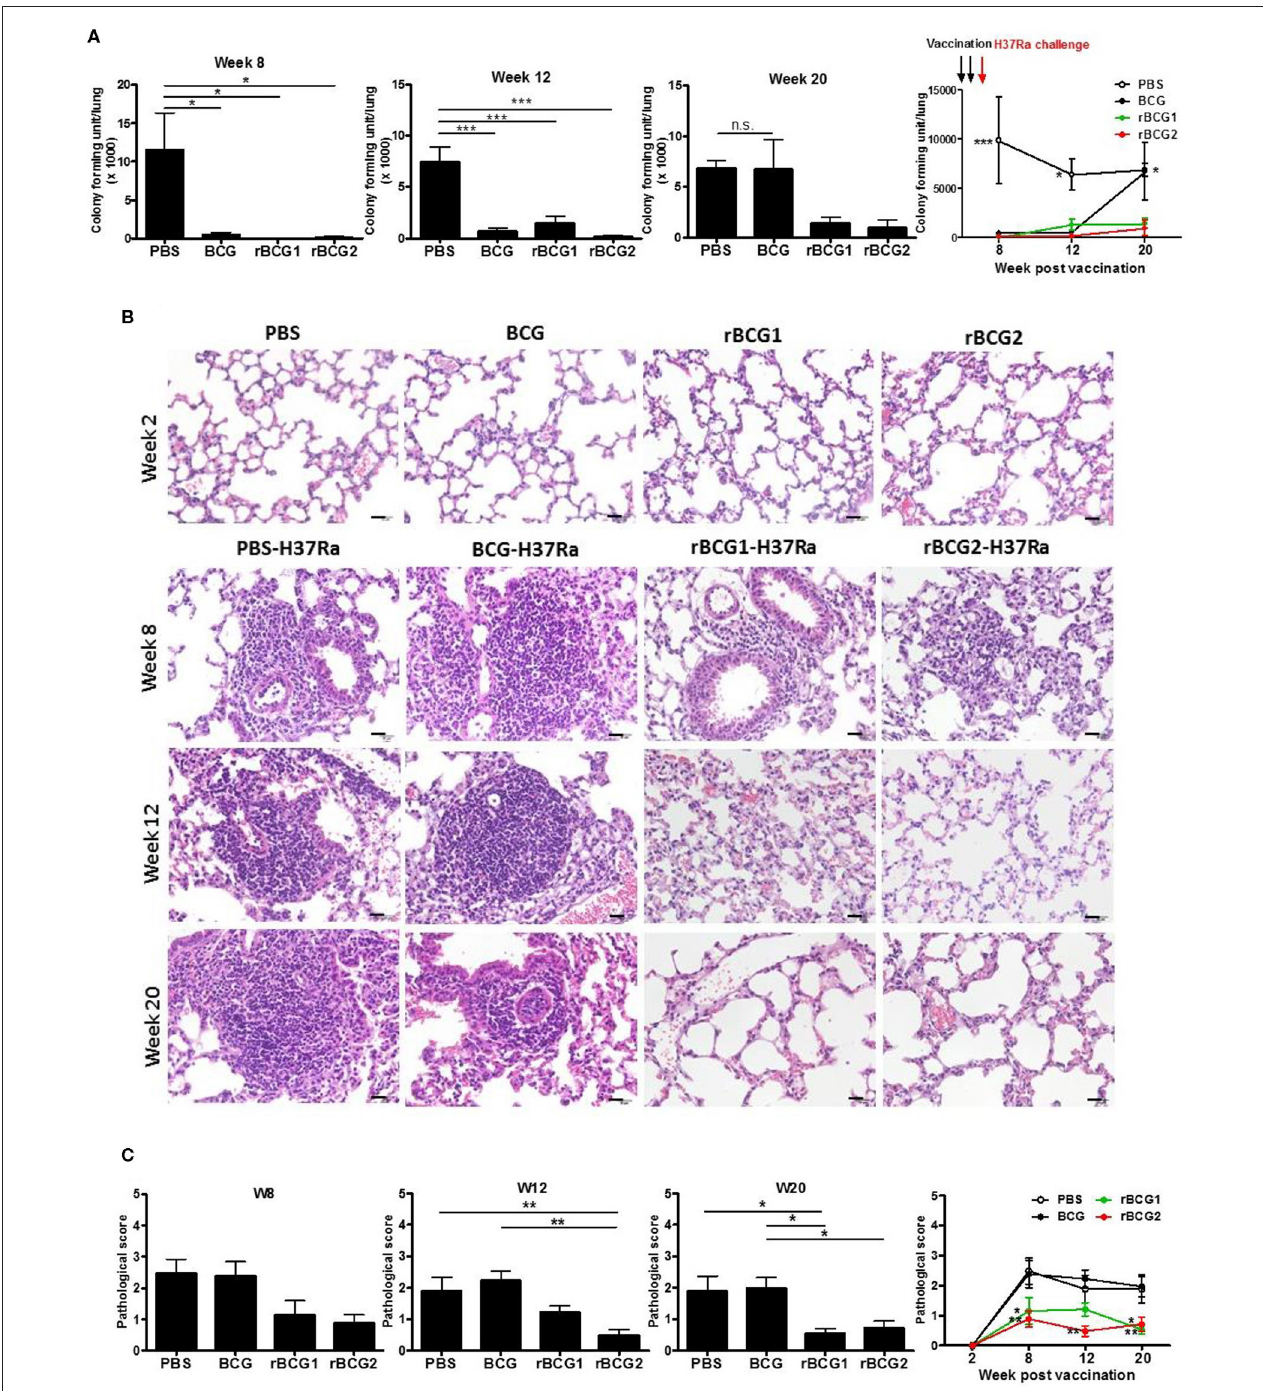
FIGURE 1 | Protection provided by recombinant BCG vaccines rBCG1 and rBCG2 against Mycobacterium tuberculosis H37Ra in mice. C57BL/6 mice were immunized with BCG, rBCG1, or rBCG2 at weeks 0 and 2, and then challenged with H37Ra at week 4 ( n = 6–7, in two independent experiments). At 2, 8, 12, and 20 weeks, the mice were sacrificed. One lung from each mouse was homogenized and the other was fixed in 3.7% formaldehyde. (A) Colony forming units (CFU) of bacterial growth in murine lung. Each plate contained 100 µ l of tissue homogenate, and each sample was titrated for two dilutions (5 × and 50 × ) and repeated in triplicate. (B) Lung samples were fixed in 3.7% formaldehyde, embedded in paraffin, sectioned, and stained with H&E; scale bar = 20 µ m. Differences among groups were determined using a one-way, non-parametric test, or two-way ANOVA with a Tukey or Bonferroni post hoc test (* P < 0.05; ** P < 0.01; *** P < 0.001; ns, non-significant). (C) Pathologic scores were determined and analyzed by H&E staining. For each time point, lung tissue from six or seven animals was examined and the mean score for each slide of five or six random views was calculated. Differences among groups were determined by one-way or two-way ANOVA with a Tukey or Bonferroni post hoc test (* P < 0.05, ** P < 0.01).